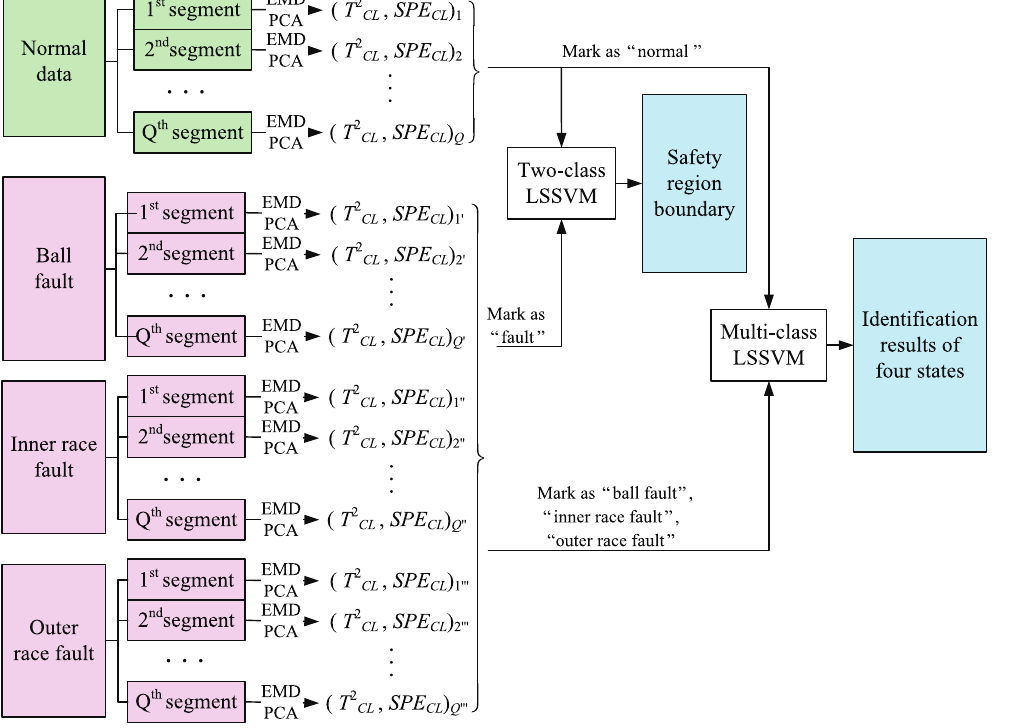
Fig. 3. The implementation process of safety region estimation and state